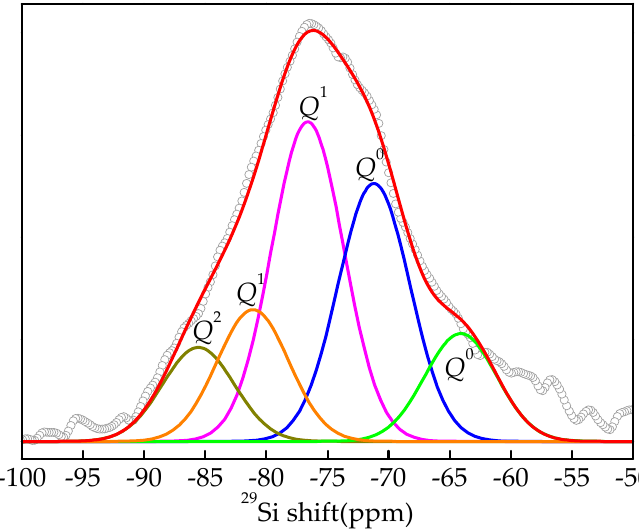
Figure 7. Deconvolution of 29 Si NMR spectroscopy of water-quenched high-titanium slag.